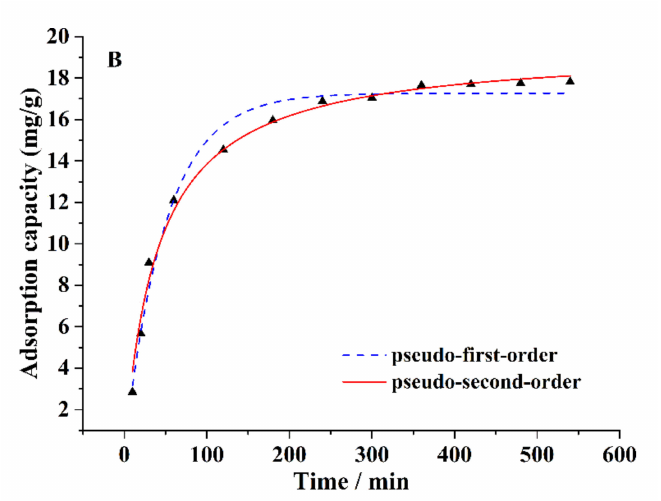
Figure 5. Adsorption kinetics of ( A ) Ca 2+ and ( B ) Mg 2+ on the CA–SC. In addition, we also used the pseudo-first-order and pseudo-second-order kinetic models to fit the experimental data. The derived kinetic models’ parameters for Ca 2+ and Mg 2+ onto CA–SC are given in Table 1. As indicated by the calculated R 2 values, the pseudo-second-order kinetic equation is more consistent with the experimental data, indicating that chemical adsorption plays an important role in the adsorption process [24]. Table 1. Kinetic parameters for Ca 2+ and Mg 2+ sorption onto the